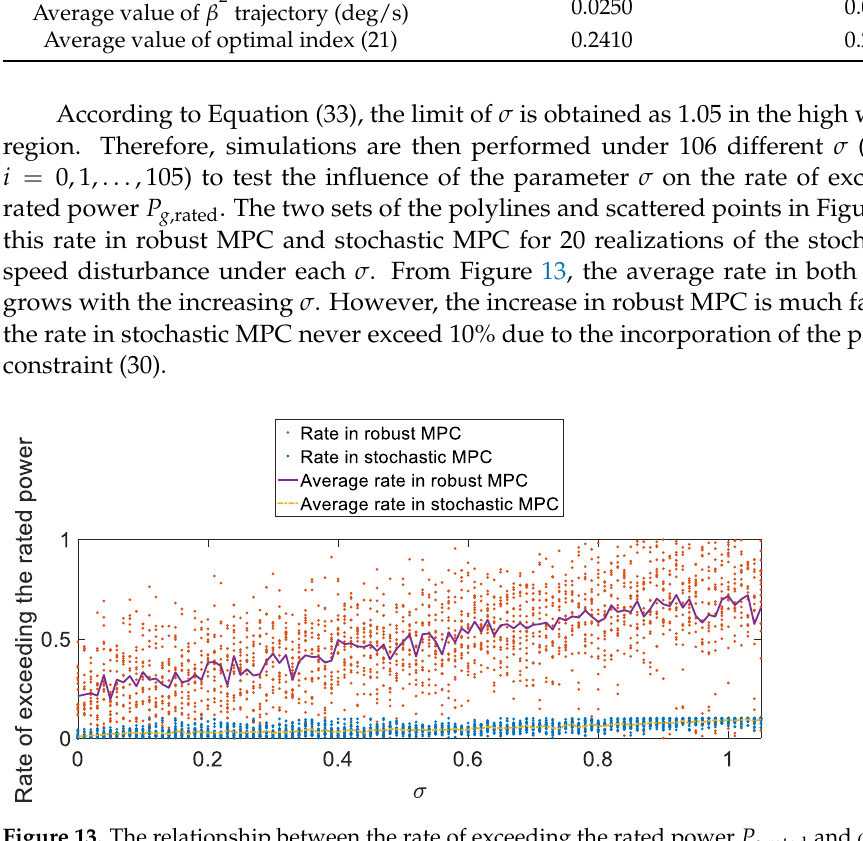
Figure 13. The relationship between the rate of exceeding the rated power P g ,rated and σ .